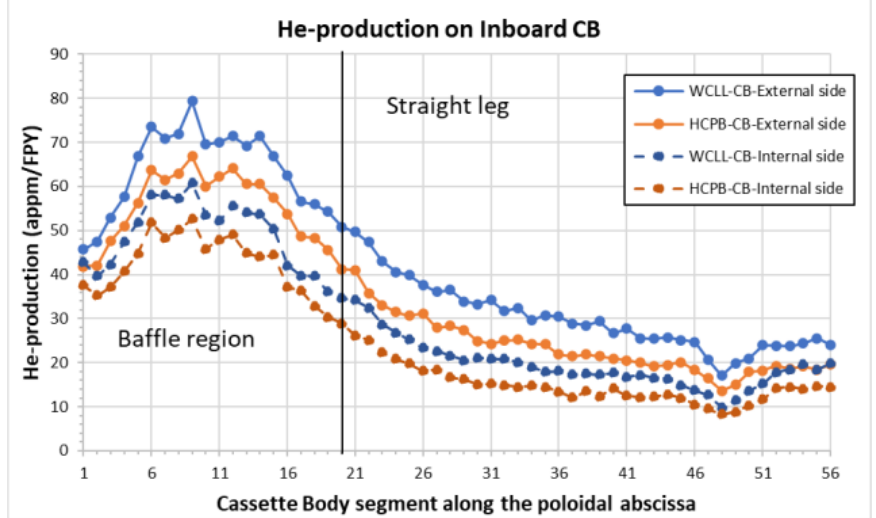
Figure 53. Inner poloidal profiles of the He-production (appm/FPY) on the first CB layer made of Eurofer, comparing the values on the external and the innermost sides, both for WCLL and HCPB blanket case. Table 10. Comparison between the total nuclear power (MW) deposited on the DEMO divertor (showing the breakdown for each single contribution) both for WCLL and HCPB blanket, consider- ing all the 48 divertor cassettes.